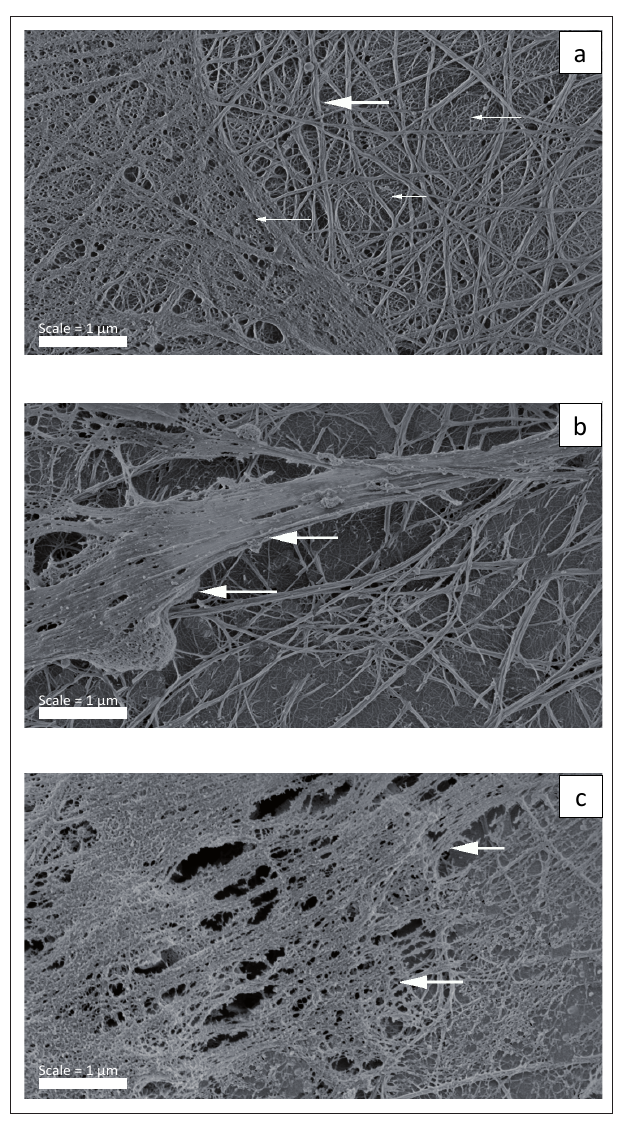
Thick, white arrows indicate major, thick fibres; thin, white arrows indicate minor, thin fibres. FIGURE 1: Control rat fibrin network.